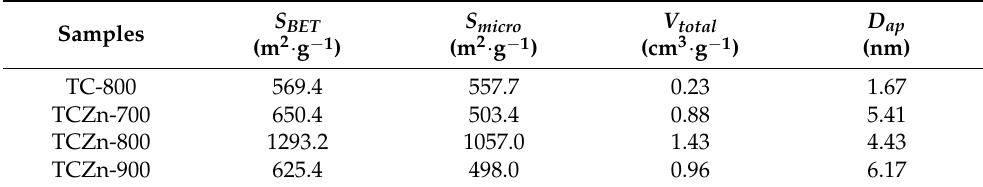
Figure 3. ( a ) N 2 adsorption/desorption isotherms and ( b ) pore size distributions for all samples. Table 1. Structural characteristics of the as-prepared materials. Table 1. Structural characteristics of the as-prepared materials.